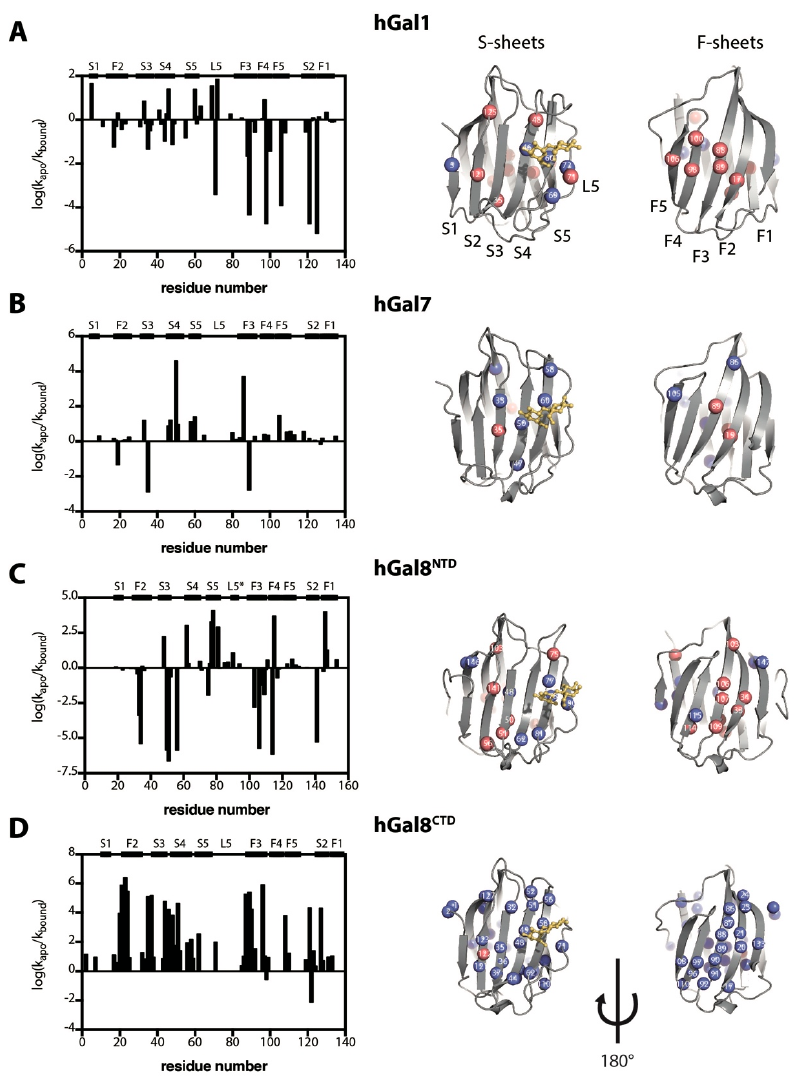
Figure 5. Comparison of galectin HDX rates between the apo- and lactose-bound forms. The logarithm of the ratio of the observed HDX rate for apo- and lactose-bound forms was plotted as a function of residue number for ( A ) hGal1, ( B ) hGal7, ( C ) hGal8 NTD , and ( D ) hGal8 CTD . The residues that exchanged over 10-fold faster (red sphere) and over 10-fold slower (blue sphere) in the bound form are indicated on the crystal structures of galectins (right panels). Crystal structure of hGal8 NTD shows a short β -sheet in L5 indicated by L5*.